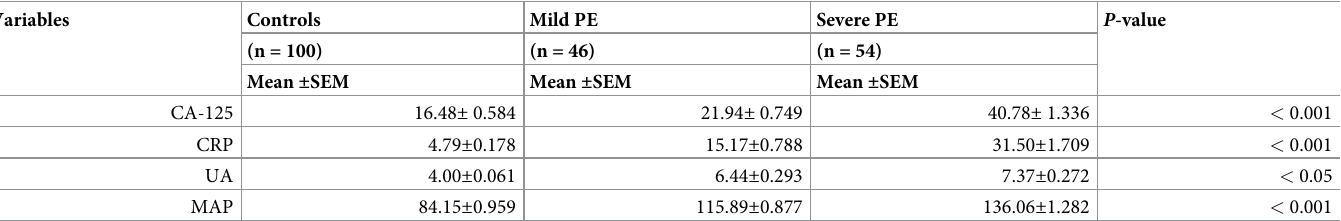
Table 2. Serum cancer antigen 125 (CA125), C-reactive protein (CRP) and uric acid (UA) and mean arterial blood pressure (MAP) in the patients and controls groups (mean ± SEM). Variables